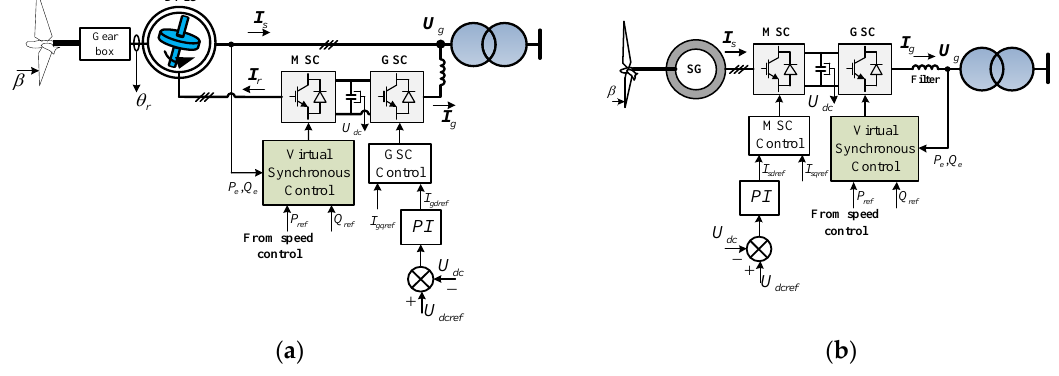
Figure 9. Enable inertial response of type-3 and type-4 WTs based on virtual synchronous control. ( a ) type-3 WT; ( b ) type-4 WT.